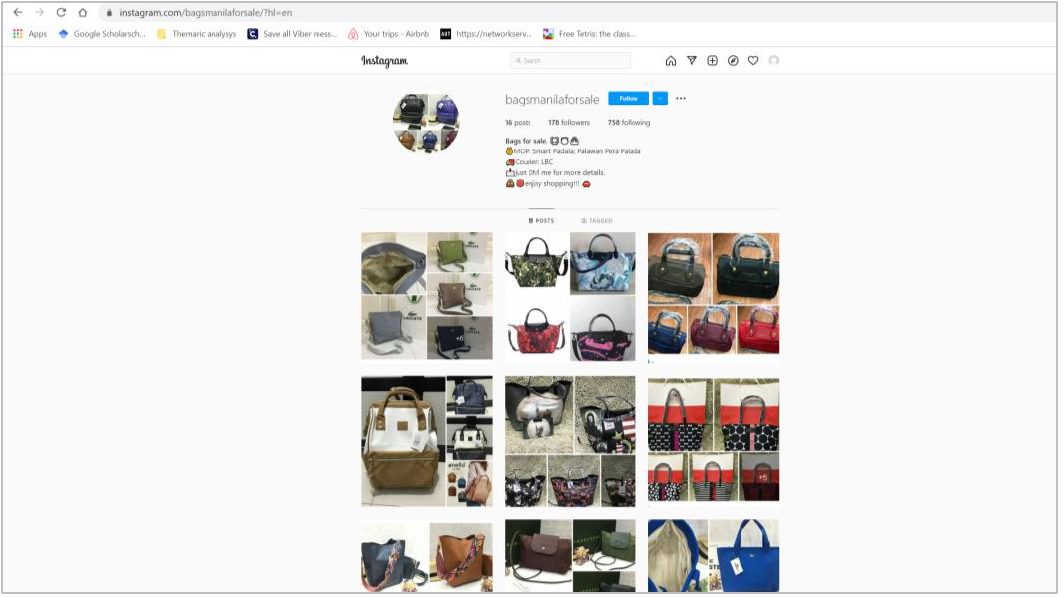
Figure 3. A pop- up store owner’s site ( Available online: https://www.instagram.com/bagsmanil- Figure aforsale/?hl=en, accessed on 23 December 2021).